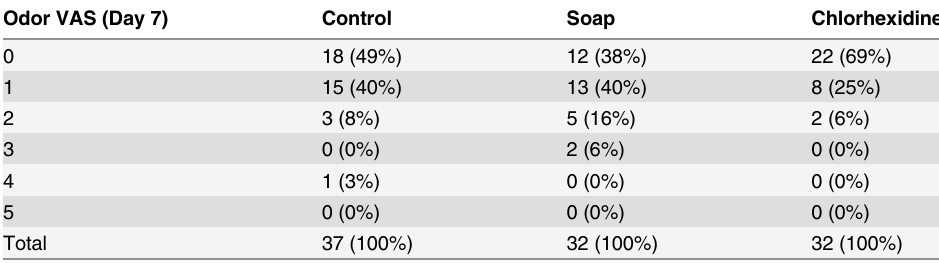
Table 2. Odor levels for each arm determined by